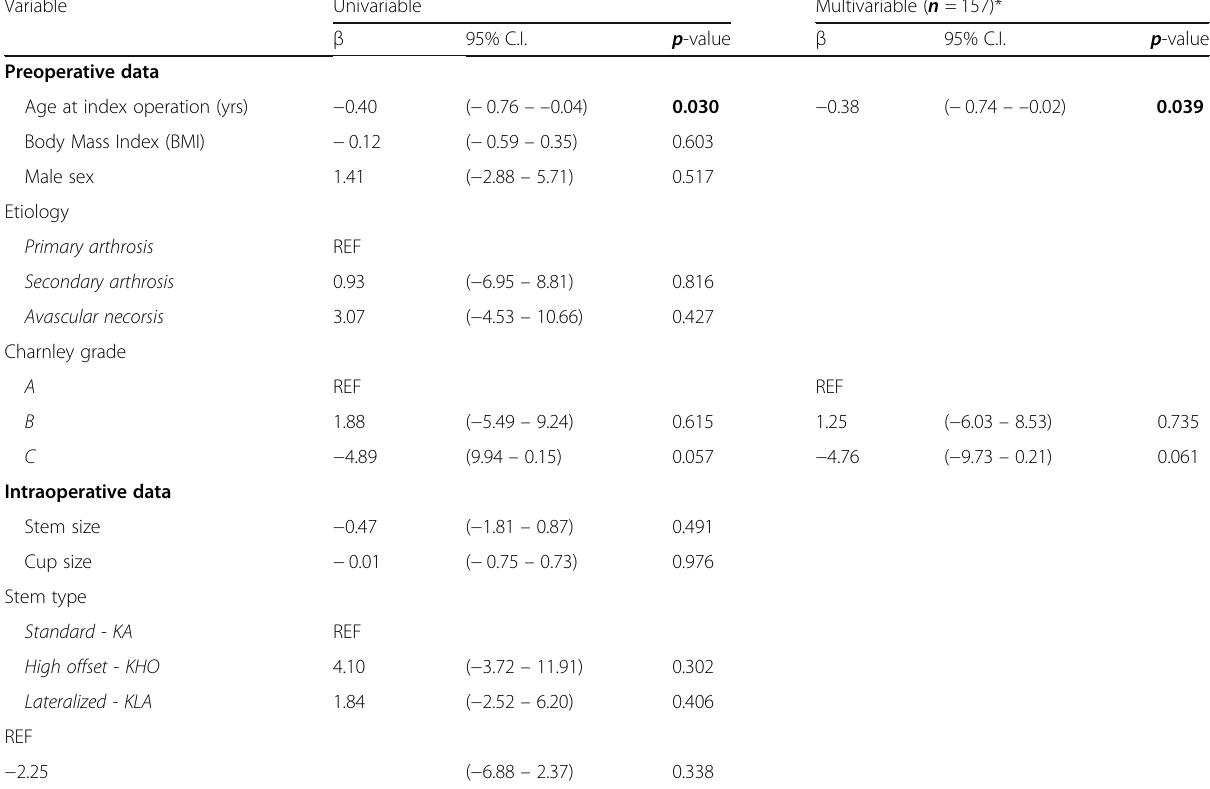
Table 3 Uni- and multi-variable regression analysis of Harris Hip Score